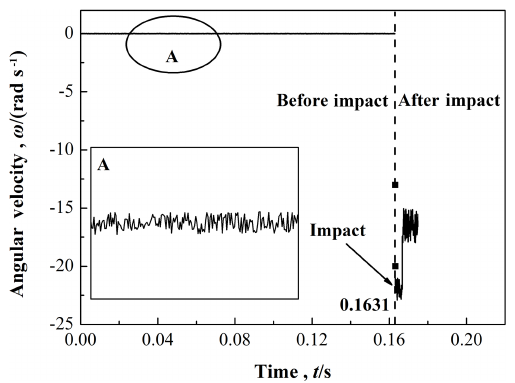
Figure 11. Angular velocity of the composite bar before and after the